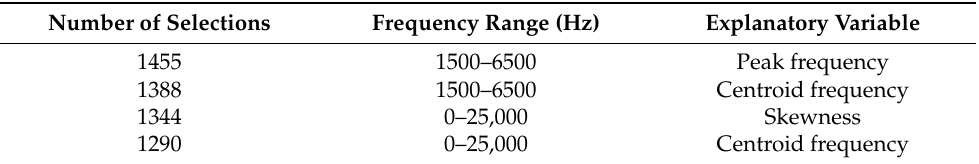
Figure 9. Leave out one cross-validation of machine learning-based diagnosis with L-RFA result for monoaxial pedicle screws reported in a previous study [10]. The blue plot shows the training data, which inevitably outputs exactly the same prediction results as training data, and the red plot shows validation data that is not included in the training data. Figure 9a,f show the analysis results at the minimum and maximum peak torques. Figure 9b–e show the typical analysis results in between. The peak torques of validation data are ( a ) 0.012 Nm, ( b ) 0.323 Nm, ( c ) 1.159 Nm, ( d ) 2.753 Nm, ( e ) 4.395 Nm, and ( f ) 5.038 Nm. Table 2. Results of explanatory variable selection by Lasso for polyaxial pedicle screws. These explanatory variables extracted more than 50% of the samples in the trial using